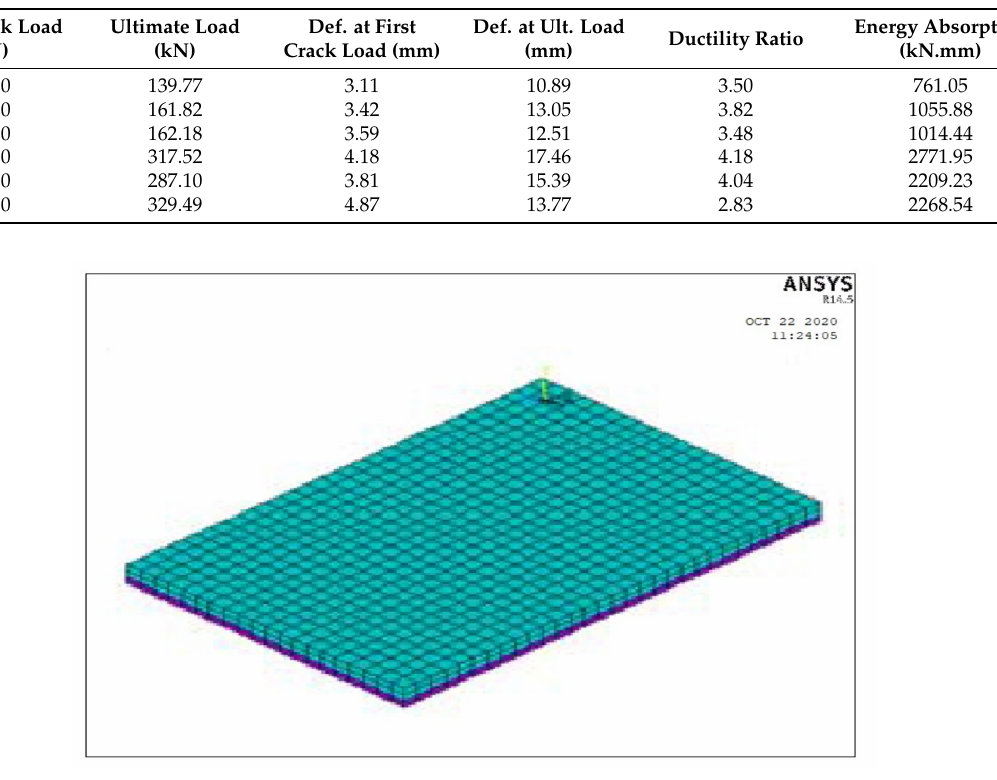
Figure 23. Finite element